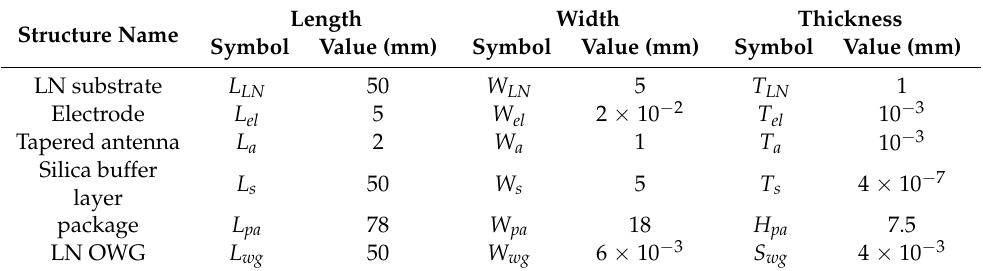
Figure 5. Transmission characteristics of OWG: ( a ) Y-branch OWG; ( b ) integrated OWG. The simulation results of the OWG MZI transmission characteristics are shown in Figure 5. Figure 5a is the simulation diagram of Y-branch waveguide. From Figure 5b, the total transmission loss of the designed MZI was 0.1188 dB. The designed parameters of the integrated OWG electric field sensor are shown in Table 1. Table 1. The parameters of the OWG electric field